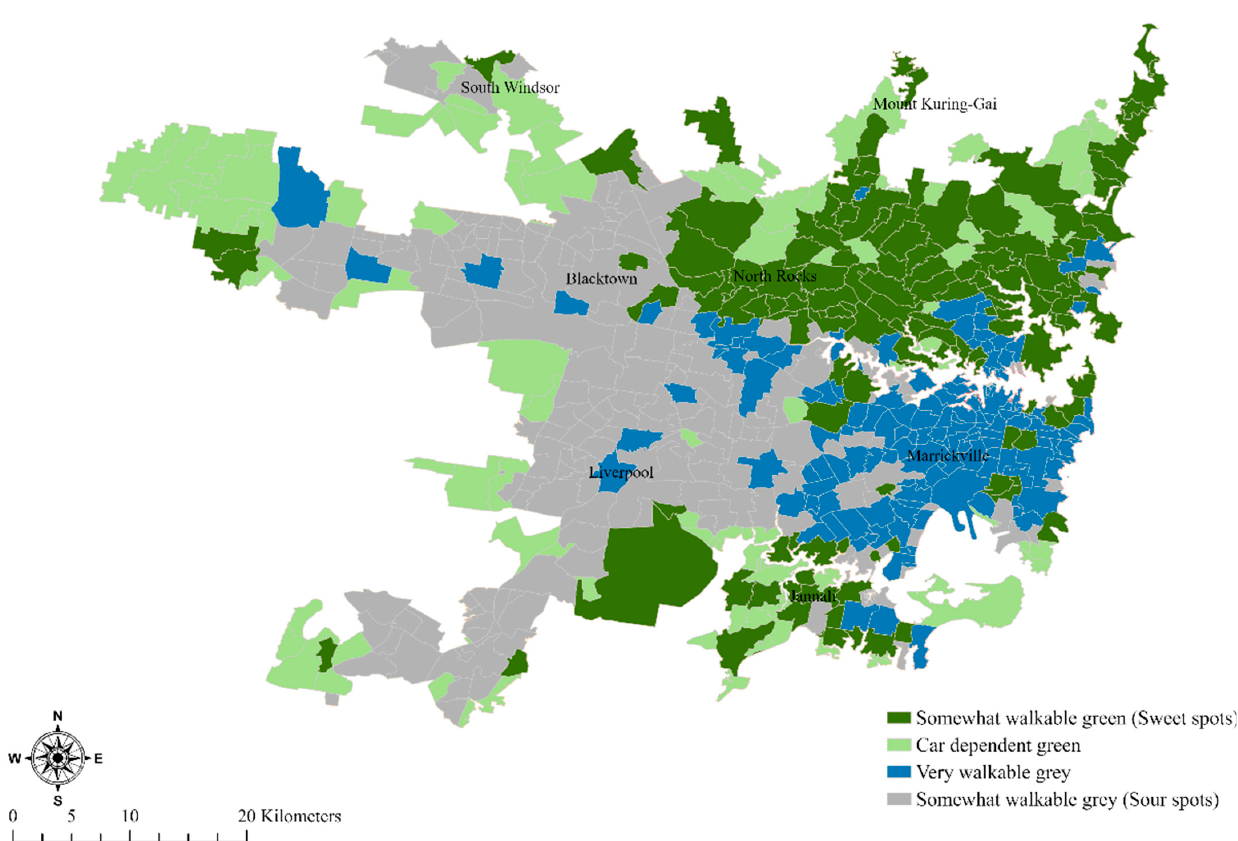
Figure 4. Map of multivariate clusters using Walk Score ® and mean NDVI at neighborhoods showing sweet and sour spots.